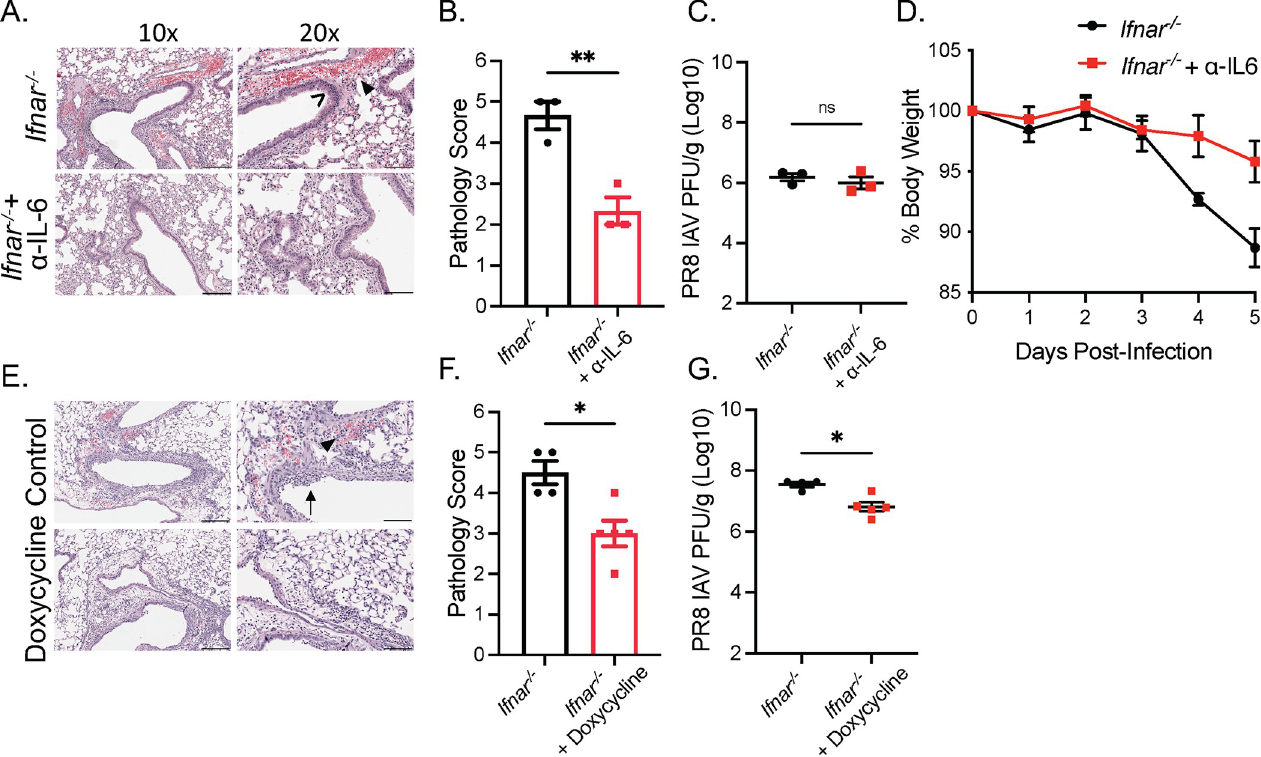
Fig 6. The immunoregulatory functions of type I IFNs during viral infection is independent of site of infection. (A) H&E staining of lung cross-sections of Ifnar -/- mice administered PBS or α -IL-6 infected with 500 PFU PR8 IAV at 5 dpi (n = 3). (B) Pathology score of (A). (C) Lung viral titers of mice in (A) at 5 dpi. (D) Average body weight of mice in (A) relative to initial starting weight. (E) H&E staining of lung cross-sections of PR8 IAV infected Ifnar -/- 5 dpi treated with or without doxycycline in drinking water for -2 to 5 dpi (n = 4–5). (F) Pathology score of (E). (G) Lung viral titers of mice in (E) at 5 dpi (n = 4–5). > indicates necrosis. ▶ indicates perivascular hemorrhaging. ! indicates immune infiltration. 10x scale bar represents 200 μ m, 20x scale bar represents 100 μ m. Data in (B),(C), (D), (F), and (G) are represented as mean ± SEM. � p < 0.05, and �� p < 0.01 (D, two-way ANOVA; B, C, F, G, two-tailed t-tests). See also S6 Fig.